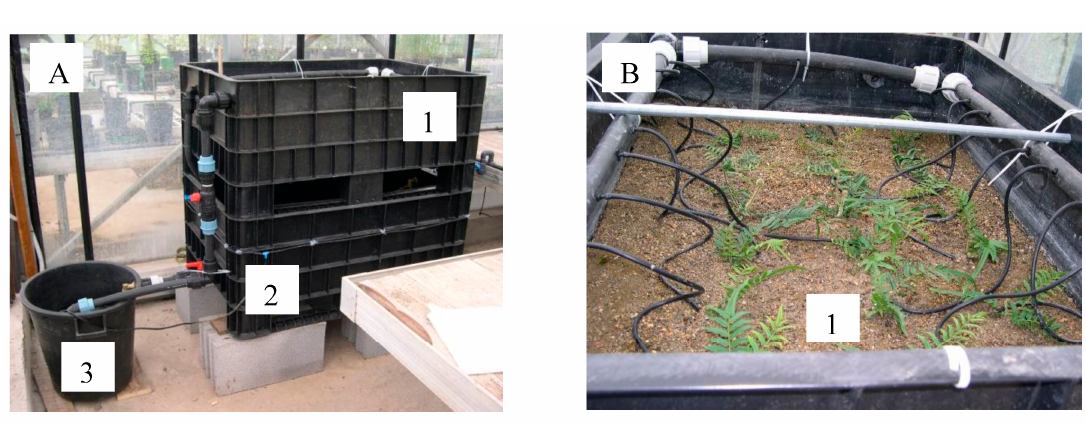
Figure 1. Semi-hydroponic growth system module ( A ) used in the experimental trial (1, tank with silica sand hosting plants; 2, drainage tank; 3, tank with pumping system). Fern plants growing in the tank 1 filled with silica sand ( B